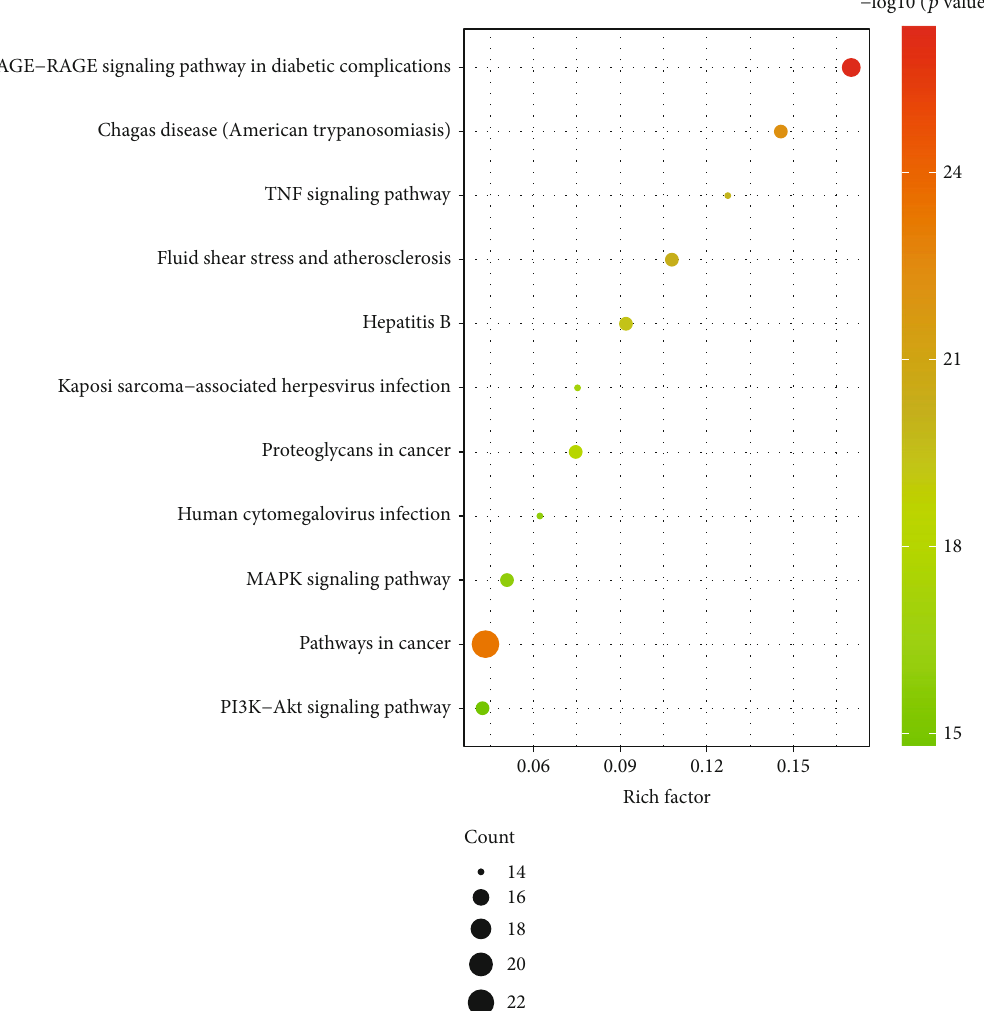
a ff ected vascular tension by its metabolic e ff ects on endothe- lial cells [26].